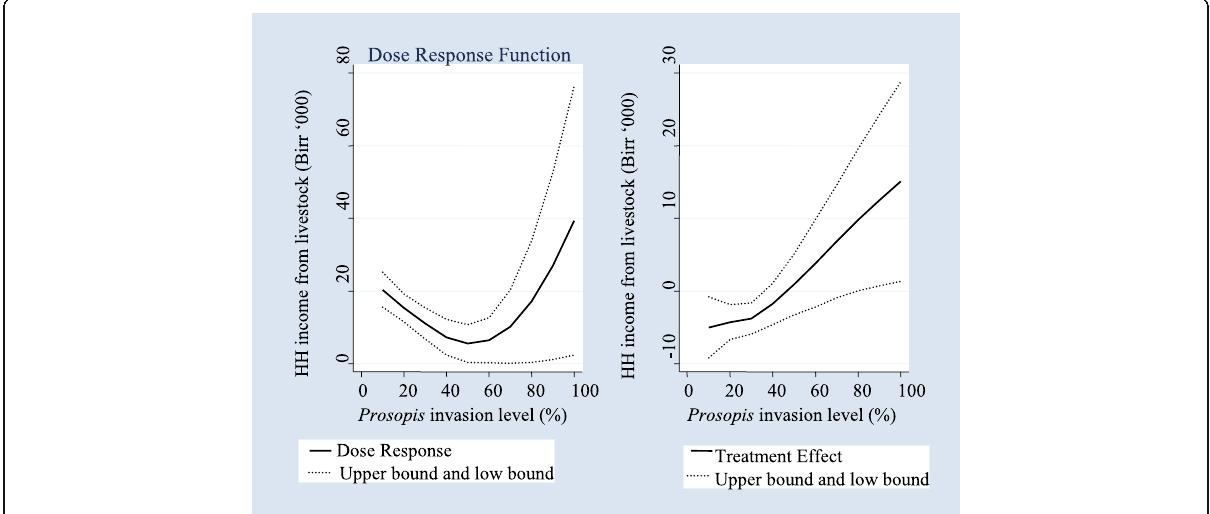
Figure 5 Estimated dose-response function, estimated derivative, and 5% confidence bands for HH income from livestock. HH,